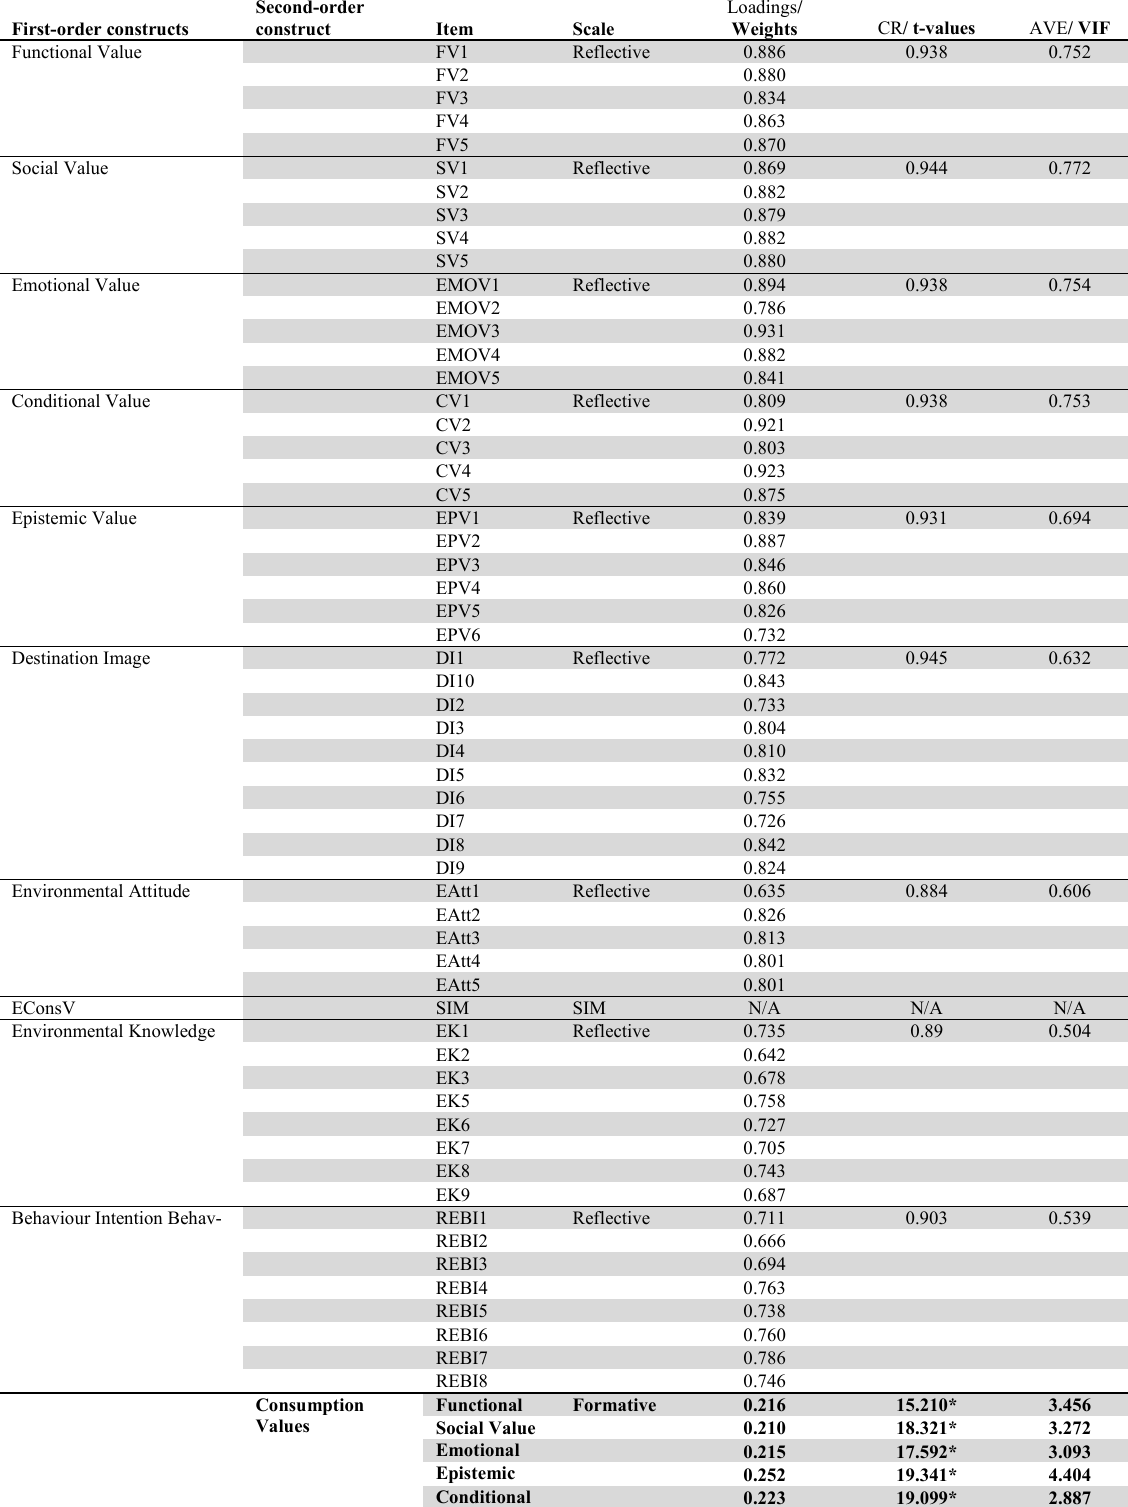
Measurement Model Convergent Validity Results First-order